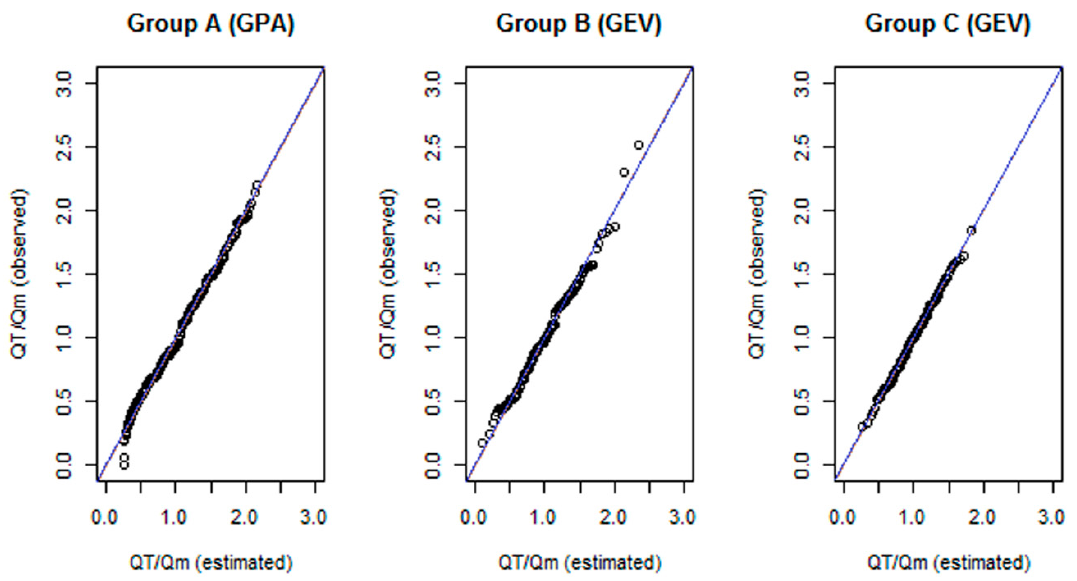
Figure 6. Quantile-quantile plots of the fitted frequency distributions for the three groups. GPA: generalized Pareto distribution; GEV: generalized extreme value distribution.